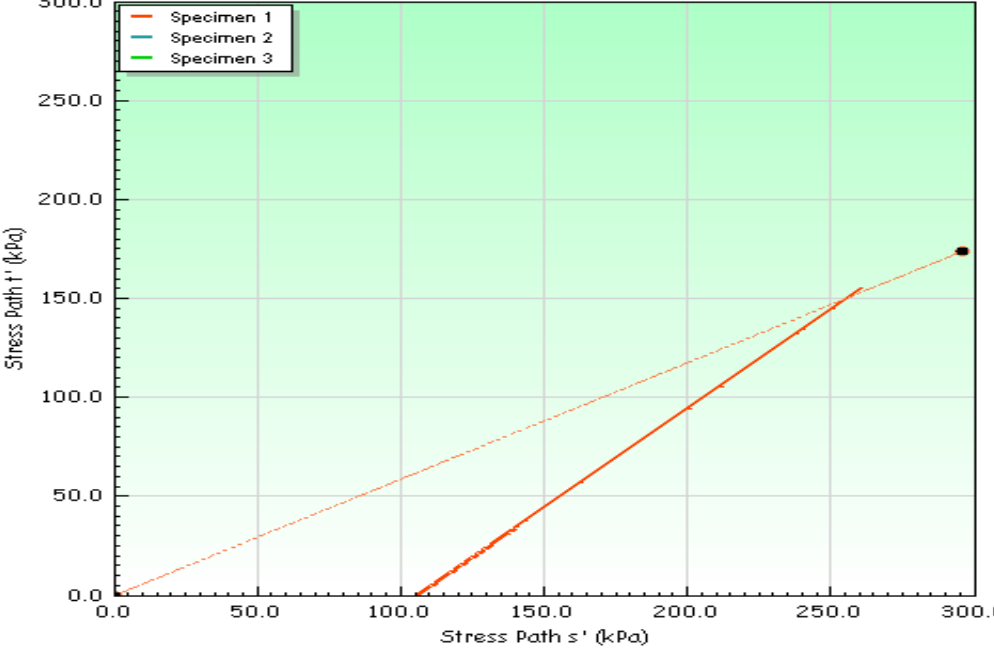
Figure A9. Stress path during tests in triaxial compression apparatus.